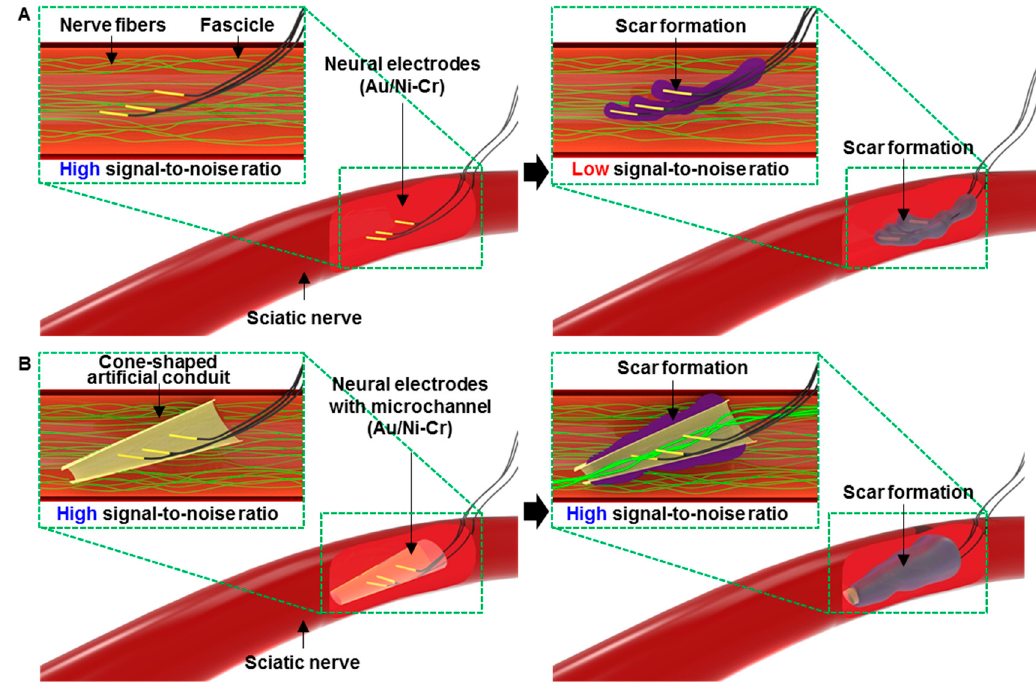
Figure 1. Overall schematics and in vivo images of wire electrodes with the artificial conduit. ( A ) Schematic of implanted wire electrode without the artificial conduit into the sciatic nerve. ( B ) Schematic of implanted neural electrode with the artificial conduit into the sciatic nerve.